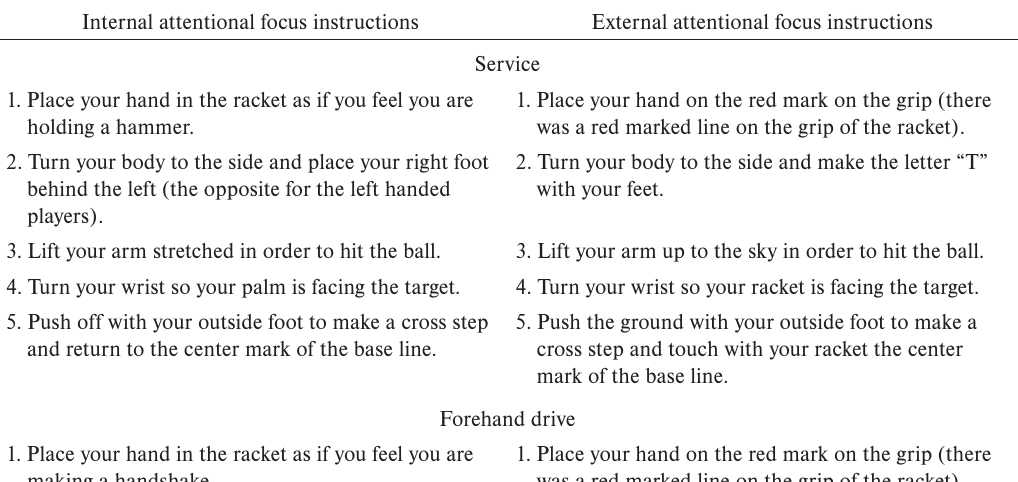
Internal and external focus of attention instructions for each skill Internal attentional focus